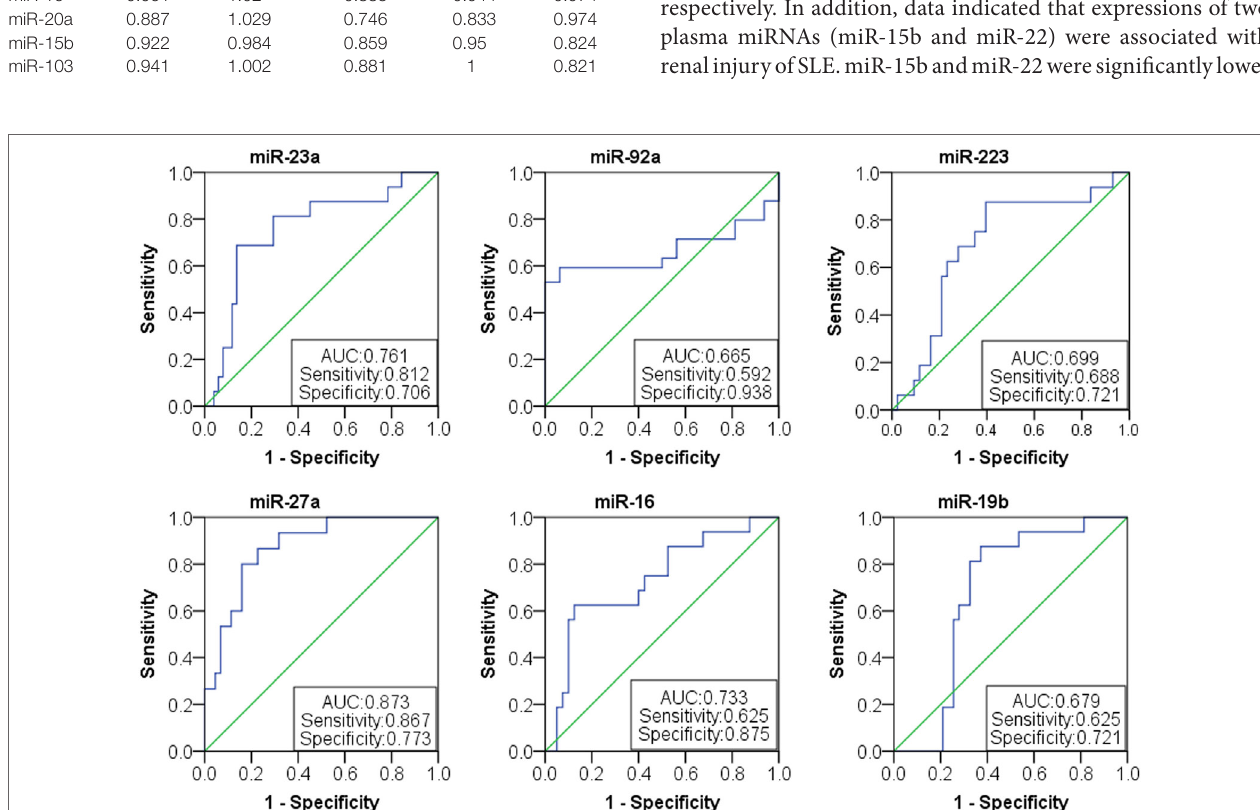
FigUre 4 | Receiver operating characteristic (ROC) curve of six microRNAs (miRNAs) for systemic lupus erythematosus (SLE) diagnosis from rheumatoid arthritis patients. The areas under curve (AUC) for miRNAs are shown in Figure 4 and Table 5 , respectively. The diagnostic sensitivity for SLE difference from healthy people was 0.59~0.87 and the specificity was